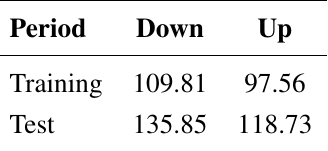
Table 3. Standard deviation of the down- and up-regulation penalties.